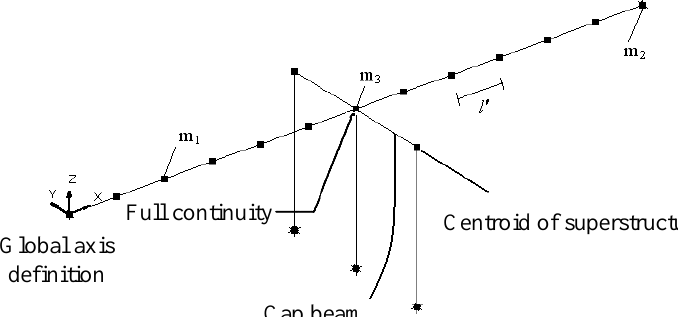
to the bridge models.